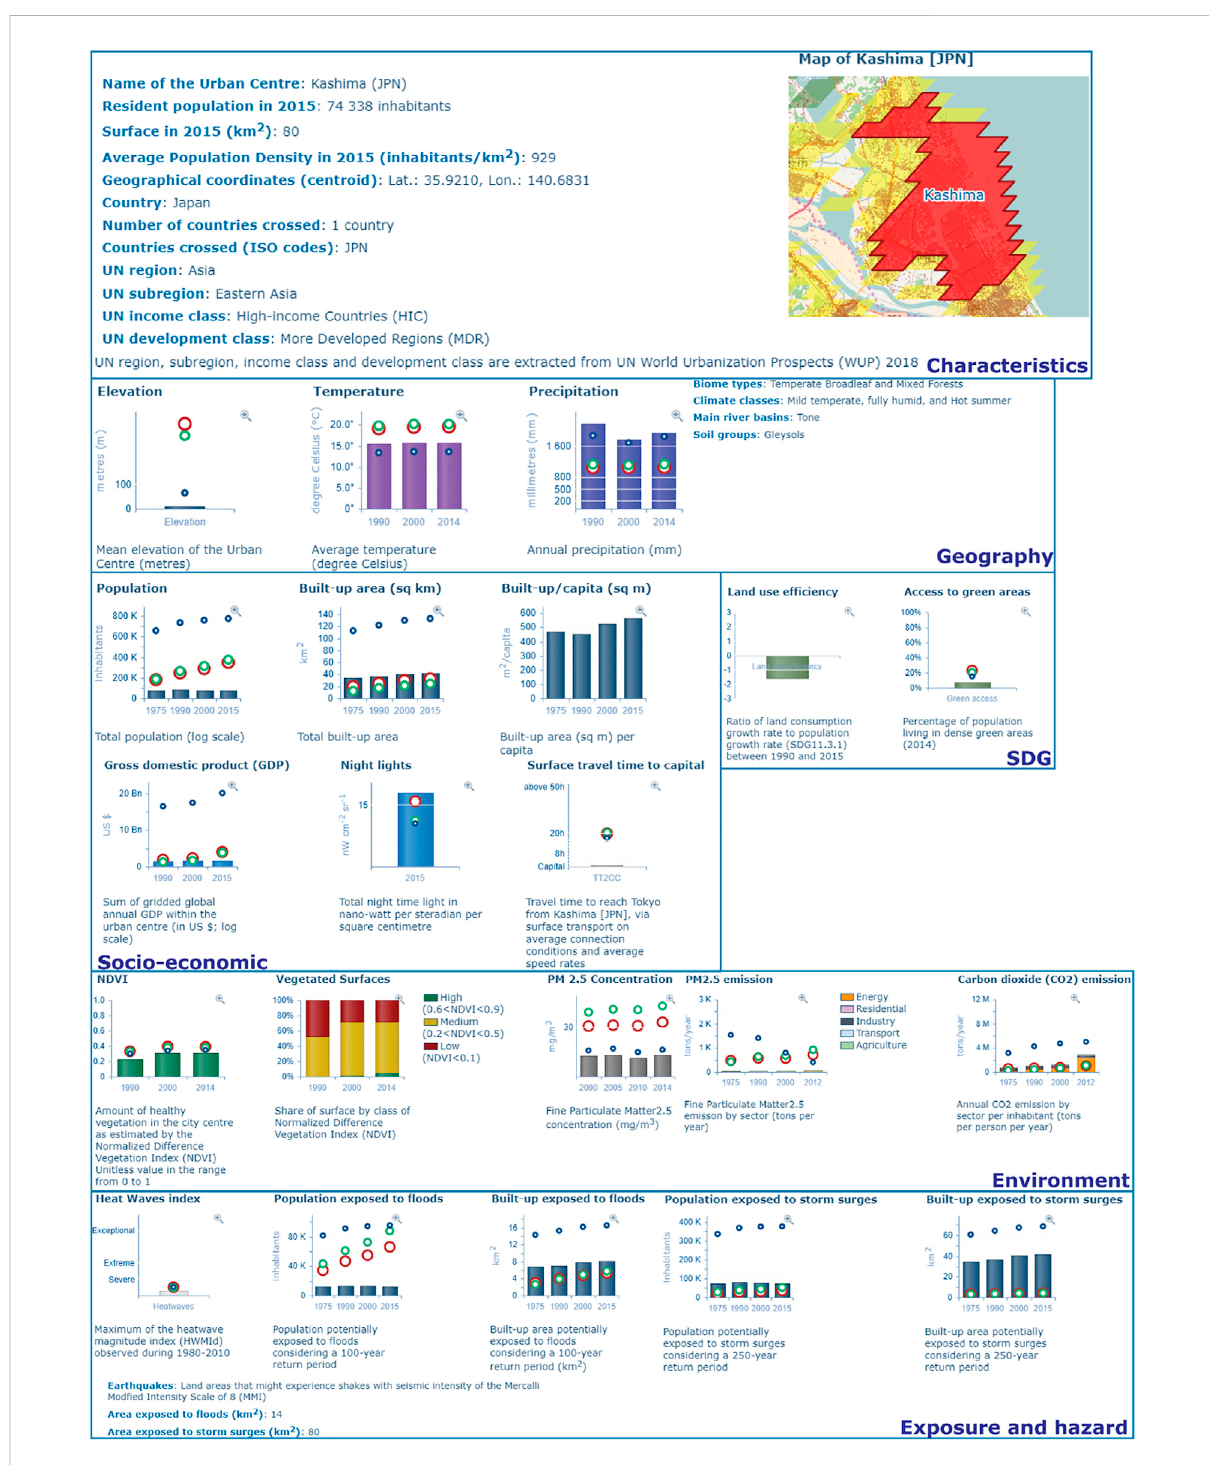
FIGURE 4 ComprehensiveoverviewoftheGHS-UCDBlistofinformationprovidedintheurbancentrepro fi leofKashima(Japan).Thepro fi lesavailablefor all 10,000 plus urban centres display a selection of data and